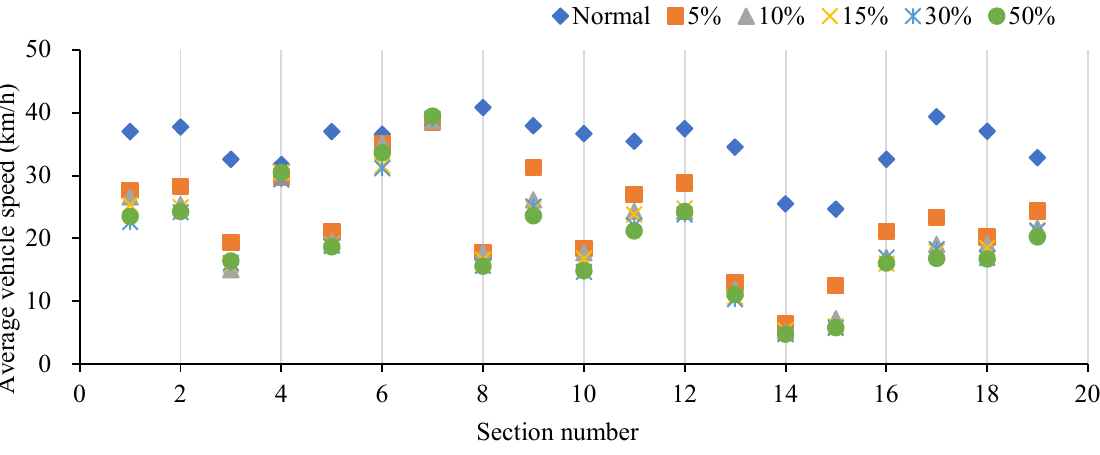
Figure 13. Speed distributions on the road sections under different cruising ratios.